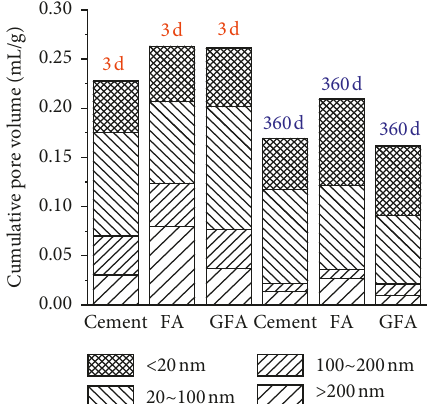
Figure 8: Cumulative pore volume